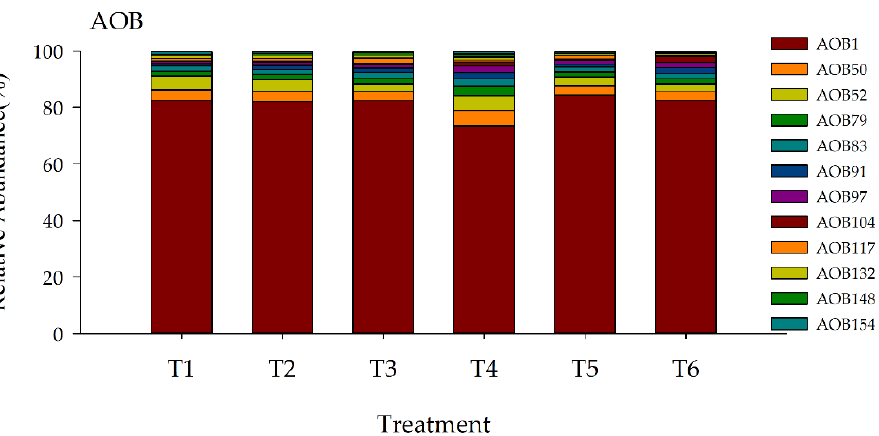
Figure 11. Relative abundance of selected Genus cluster in the M2 module of AOB among dominant 98 OTUs in response to organic fertilizer substitution. Twelve OTUs were selected to account for more than 1% of each treatment. T1: inorganic fertilizer; T2: 50.0% organic fertilizer; T3: 37.5% organic fertilizer; T4: 25.0% organic fertilizer; T5: 12.5% organic fertilizer; T6: no fertilizer.